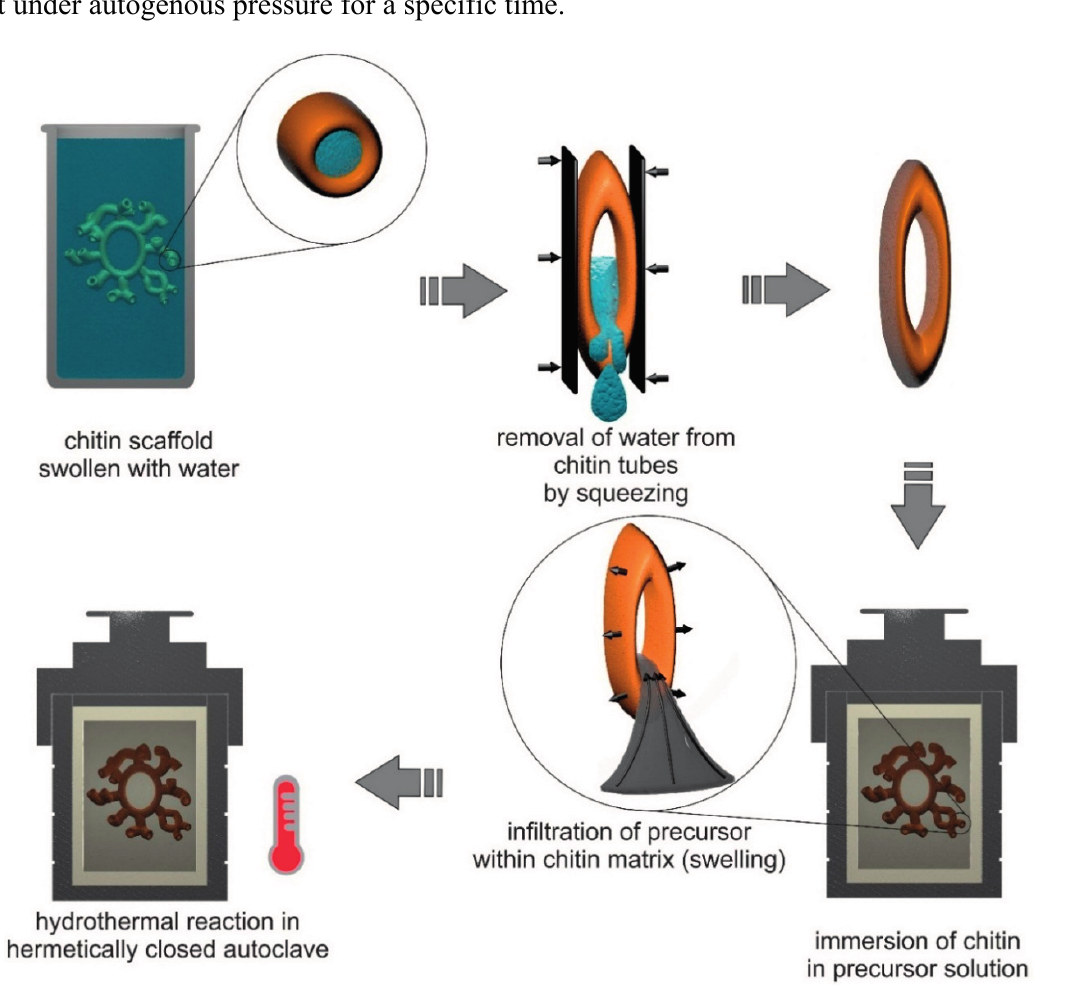
Figure 4. A schematic view for the exchange of different soaking solutions within the tubular 3D chitinous scaffold of sponge